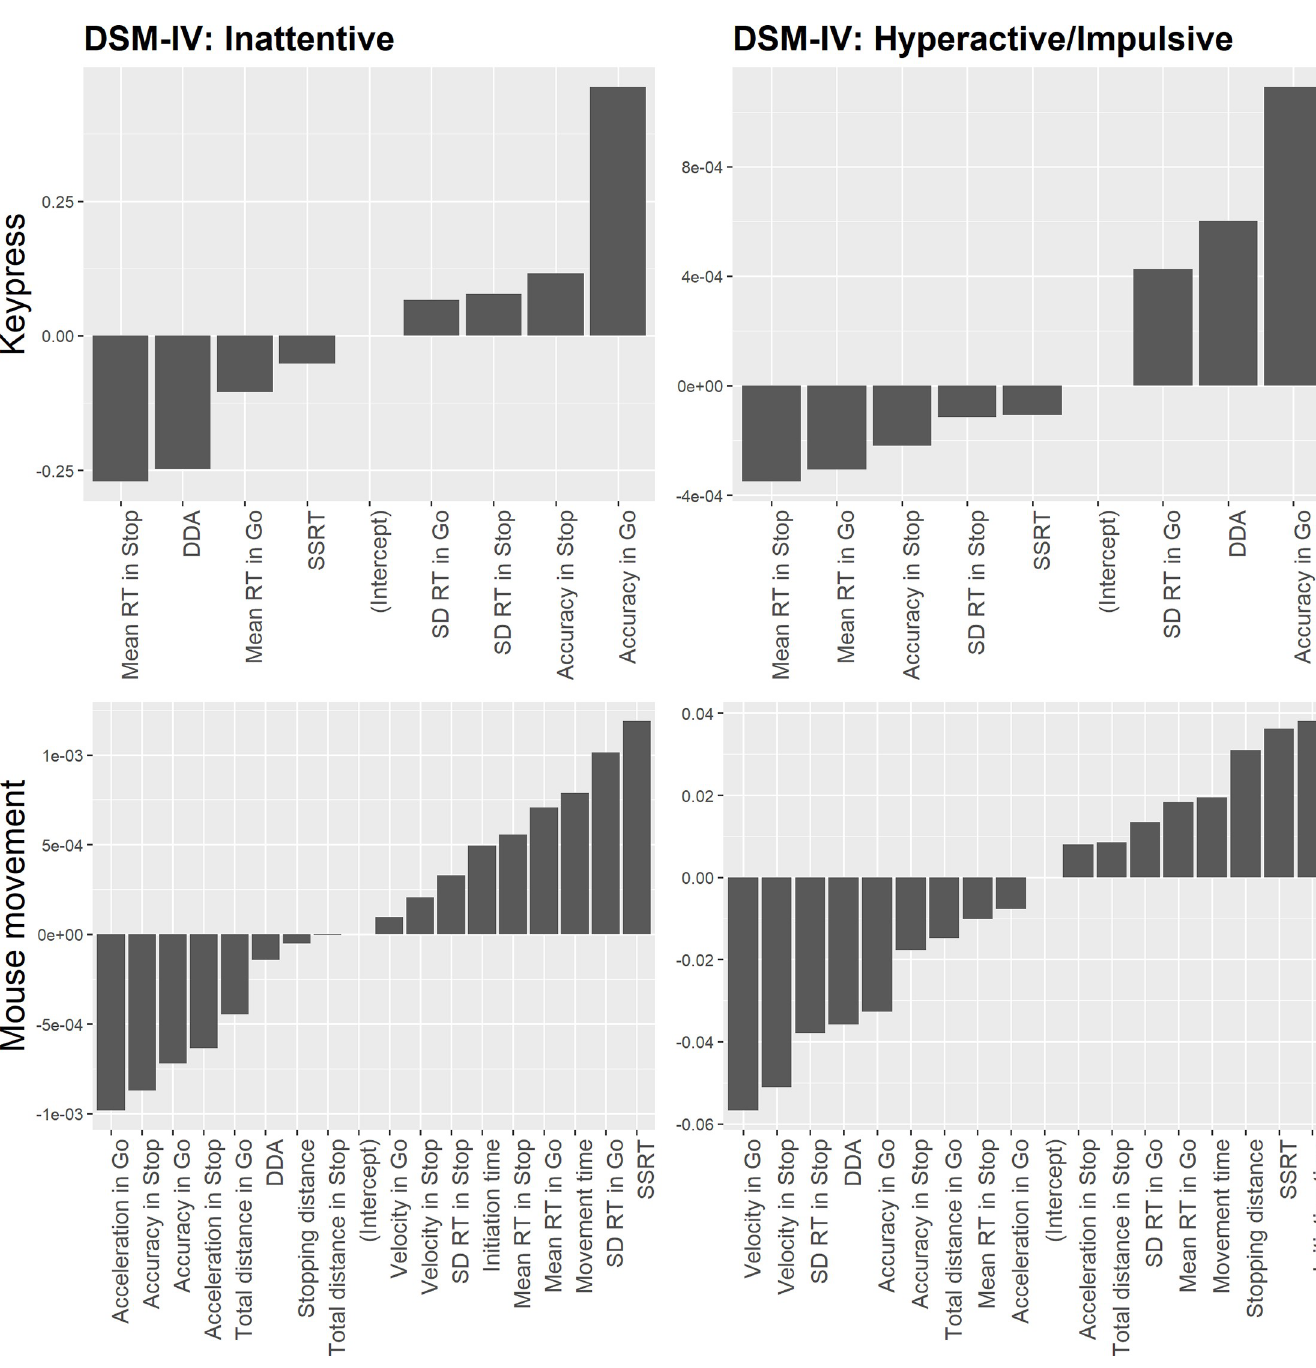
Fig 4. Ridge regression coefficients in keypress and mouse movement conditions. Note : coefficient value closer to zero indicates less importance. DDA = Direction discrimination